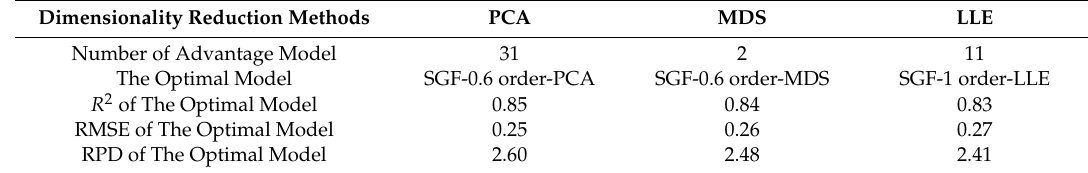
Table 5. Statistics for Advantage Models and Optimal